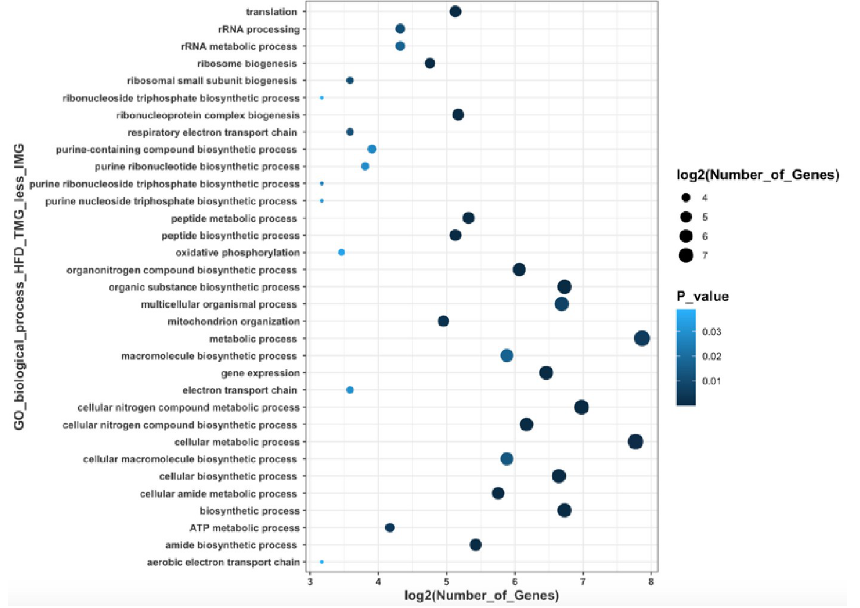
Fig 4. Summary of GO biological processes that are downregulated in the TMG of dams fed a HFD.